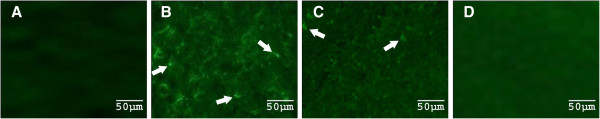
Depict the immunofluorescent pattern of GFAP positive cells in striatum and midbrain respectively, exhibiting markedly increased, ramified form with many fine processes in MPTP treated mice. GFAP immunoreactivity was mild in the striatum and midbrain of control (Group I) and AS treated mice (Group III). Immunoflurosence expression of GFAP in striatal tissue. A: Control (group 1); B: MPTP induced (group II); C: MPTP induced + As treated (group III); D: Drug Control (group IV).